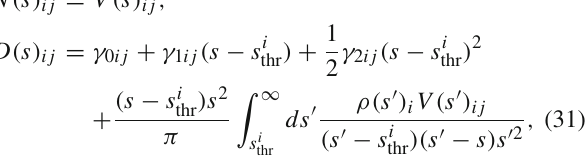
= 0 . 775 q = 0 . max max